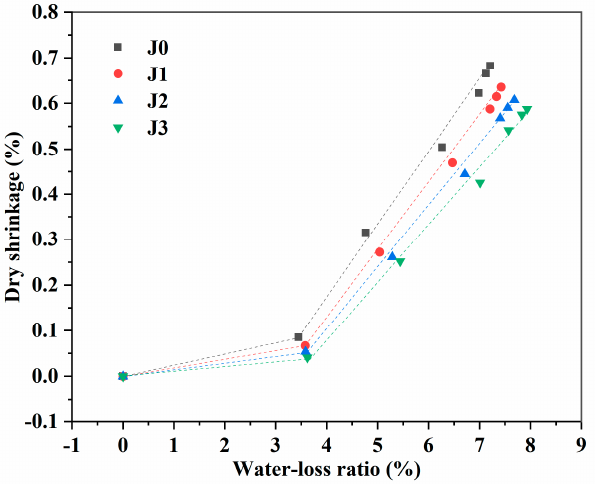
Figure 4. Relationship between dry shrinkage and Water-Loss ratio.